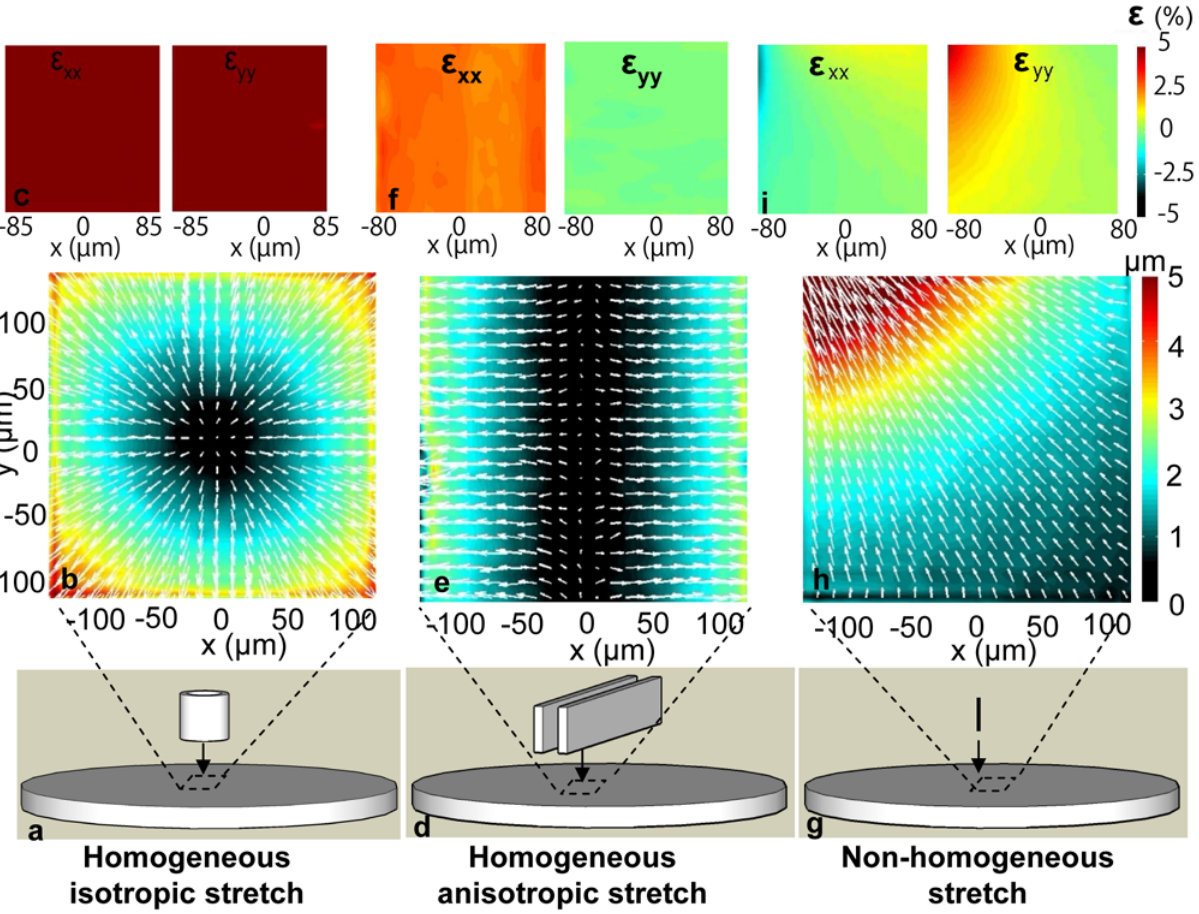
Figure 1. Cell Mapping Rheometry (CMR). Localized vector displacements in the gel are indicated by arrows, and their magnitude by color. a–c, Indentation of the gel with an annular punch indenter imposes a homogeneous isotropic biaxial stretch within the central region of the indenter. d– f, When the gel is indented with two parallel plates, the corresponding stretch field in the central gel region is homogeneous, anisotropic and uniaxial. g–i , When the gel is indented with a microneedle, a non-homogeneous stretch is imposed.